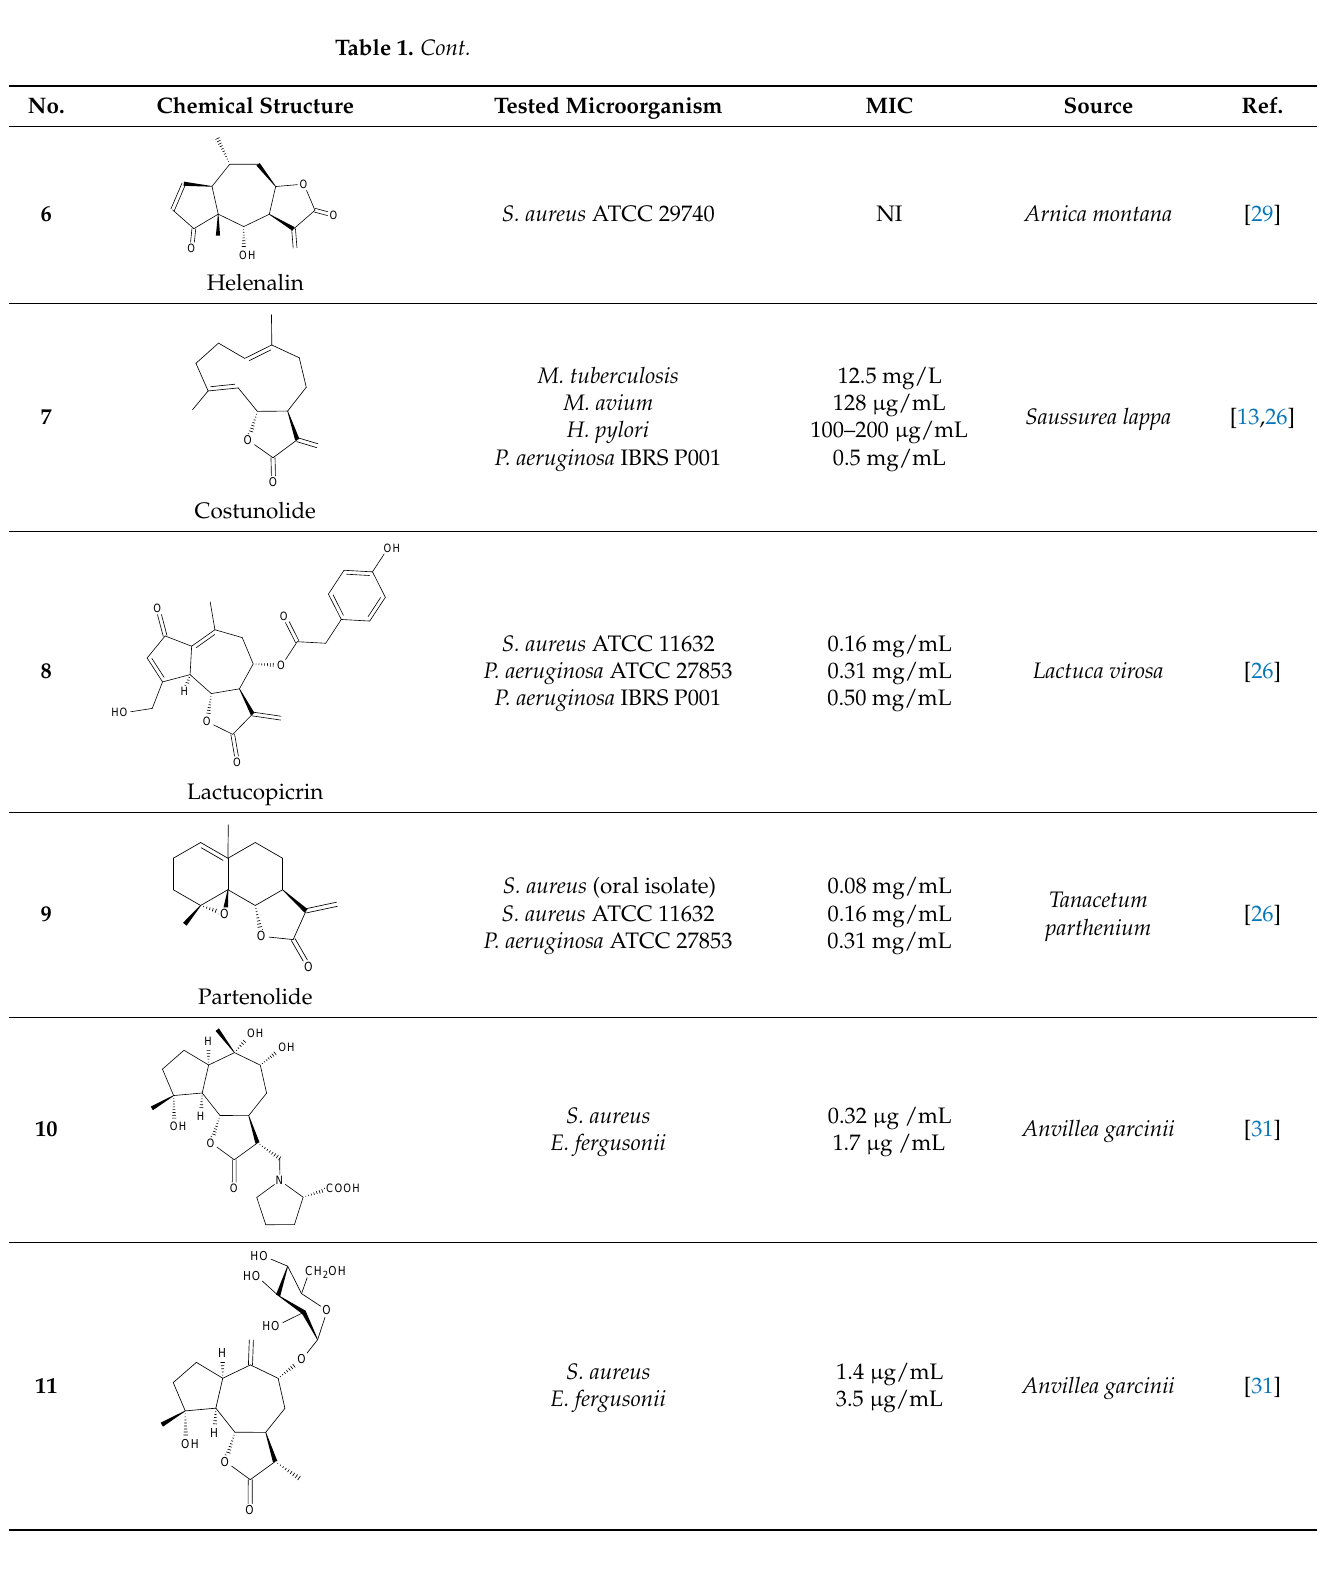
Table 1. Antimicrobial activity of lactones isolated from plants.